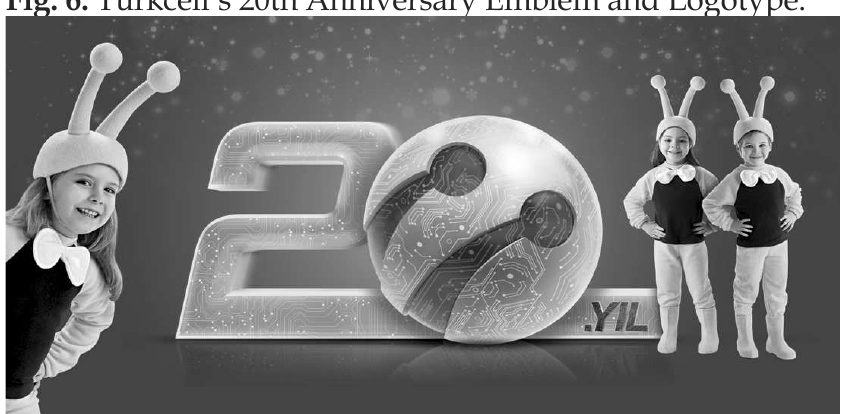
Fig. 6. Turkcell’s 20th Anniversary Emblem and Logotype.